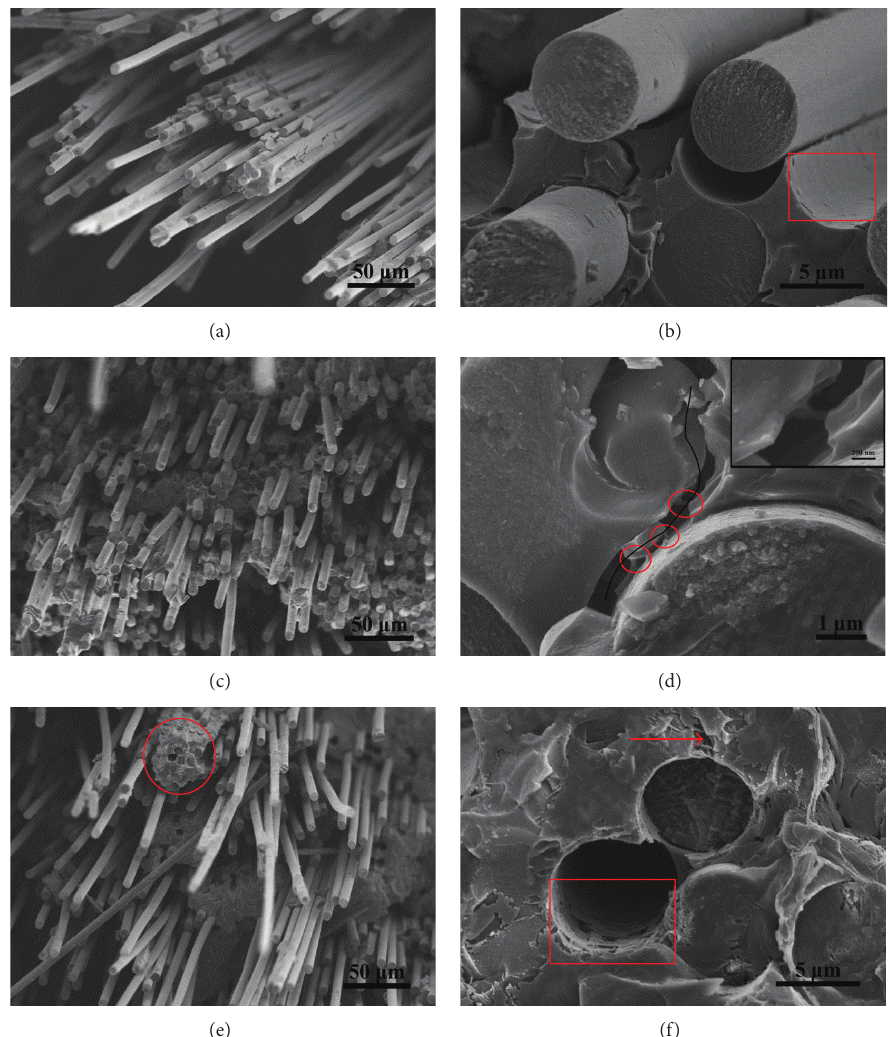
Figure 4: SEM images of the fracture morphologies after three-point bending test of (a) (b) C f /SiC, (c) (d) C f /1%CNTs/SiC, and (e) (f) C f